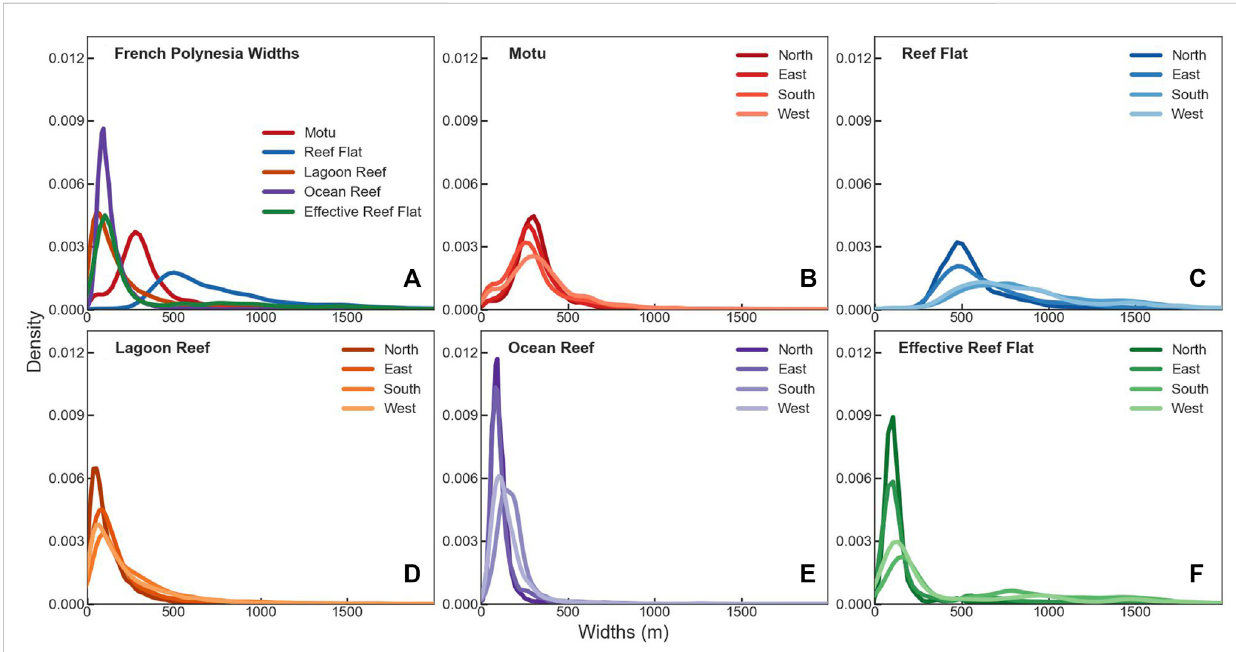
FIGURE 4 Density functions for width calculations in French Polynesia on a per-point basis. (A) Atoll wide widths, binned by cardinal directions for (B) motu width, (C) total reef fl at width, (D) lagoon reef width, (E) ocean reef width, -and (F) effective reef- fl at width.